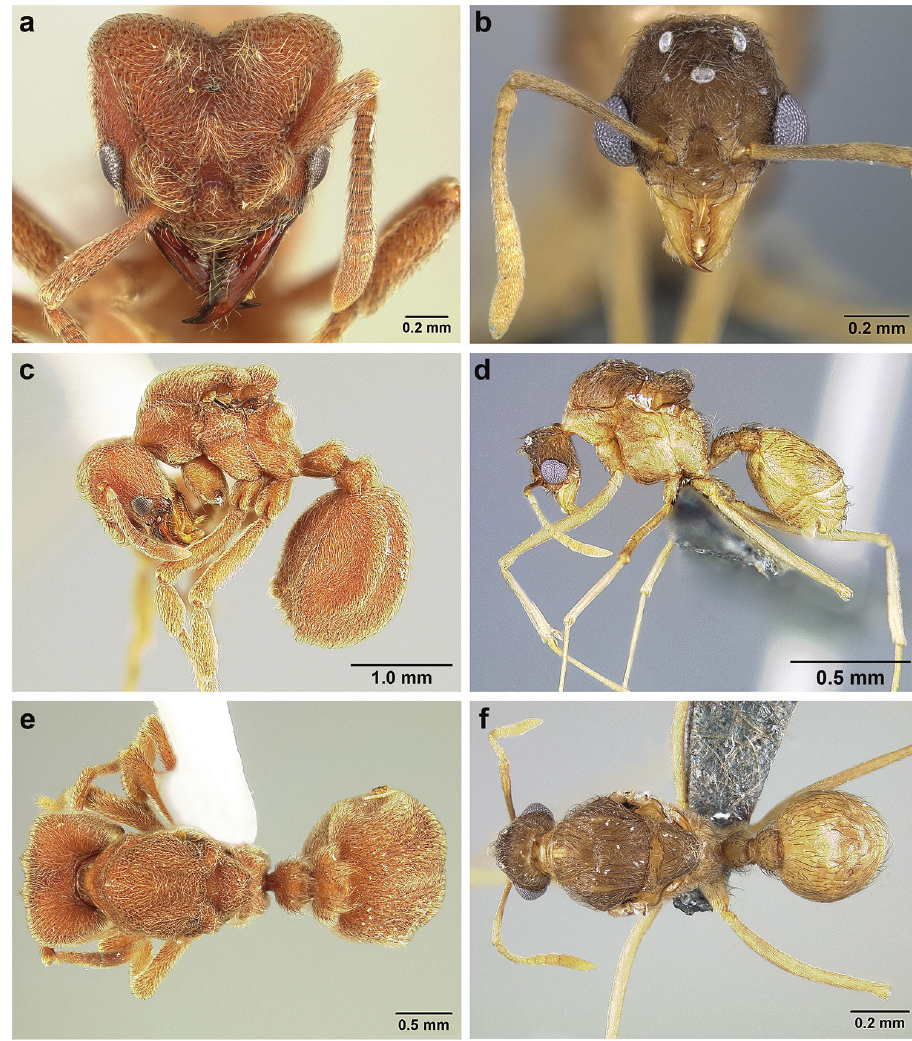
Figure 45. S. opacus queen and male; head, lateral profile, and dorsal view. Queen (USNMENT00305214) ( a, c, e ) Male (USNMENT01125314) ( b, d, f ). eye, medially curved before fading. Notauli and mesoscutal line faint, parapsidal lines thin, groove between axillae smooth, sometimes weakly transversely costate. Propo- deum without denticles or carinae. Petiole and postpetiole with lateral denticles very reduced, dorsal denticles